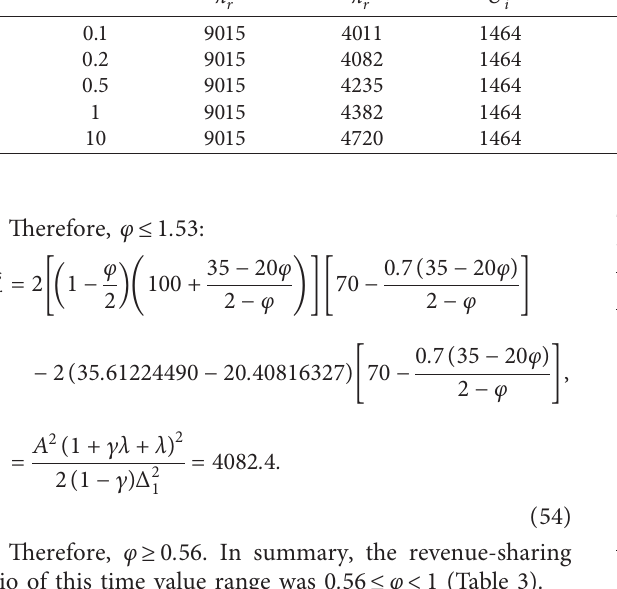
Table 2: Comparison of utility between two decision-making situations in manufacturer’s peer-induced equity concerns. 0.1 φ